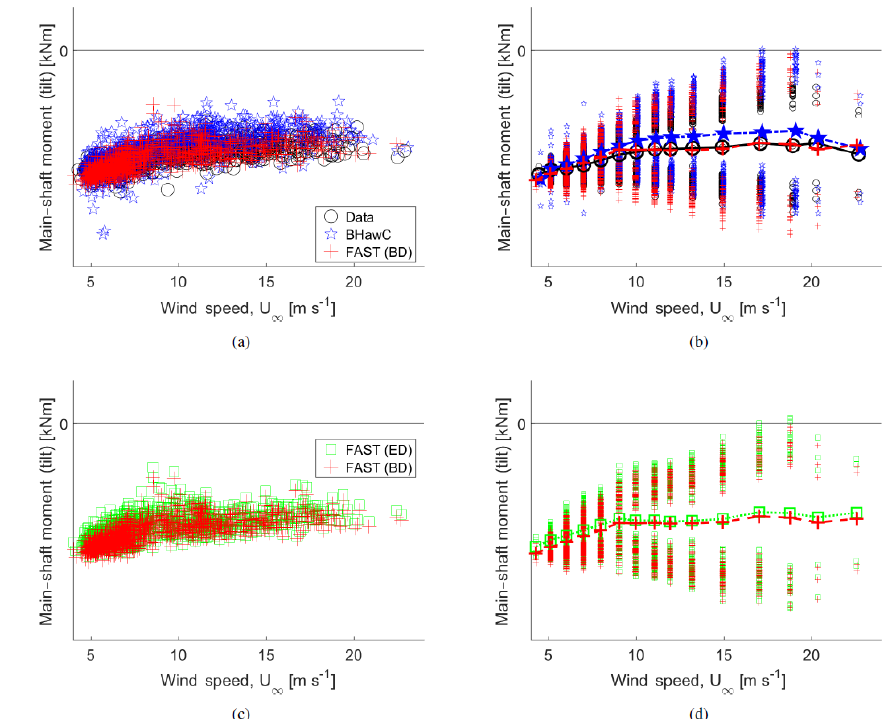
Figure 9. Main-shaft bending moment – tilt (nonrotating coordinate system). (a) Individual 10min averages from experimental data, BHawC, and FAST (BD). (b) Binned averages of data in (a) are denoted by points connected by lines; the scatter above and below these data denotes plus or minus 1 standard deviation, respectively, of the individual 10min data sets in that bin. (c) Individual 10min averages from FAST (BD) and FAST (ED). (d) Binned averages of data in (c) are denoted by the points connected by lines; the scatter above and below these data denotes plus or minus 1 standard deviation, respectively, of the individual 10min data sets in that